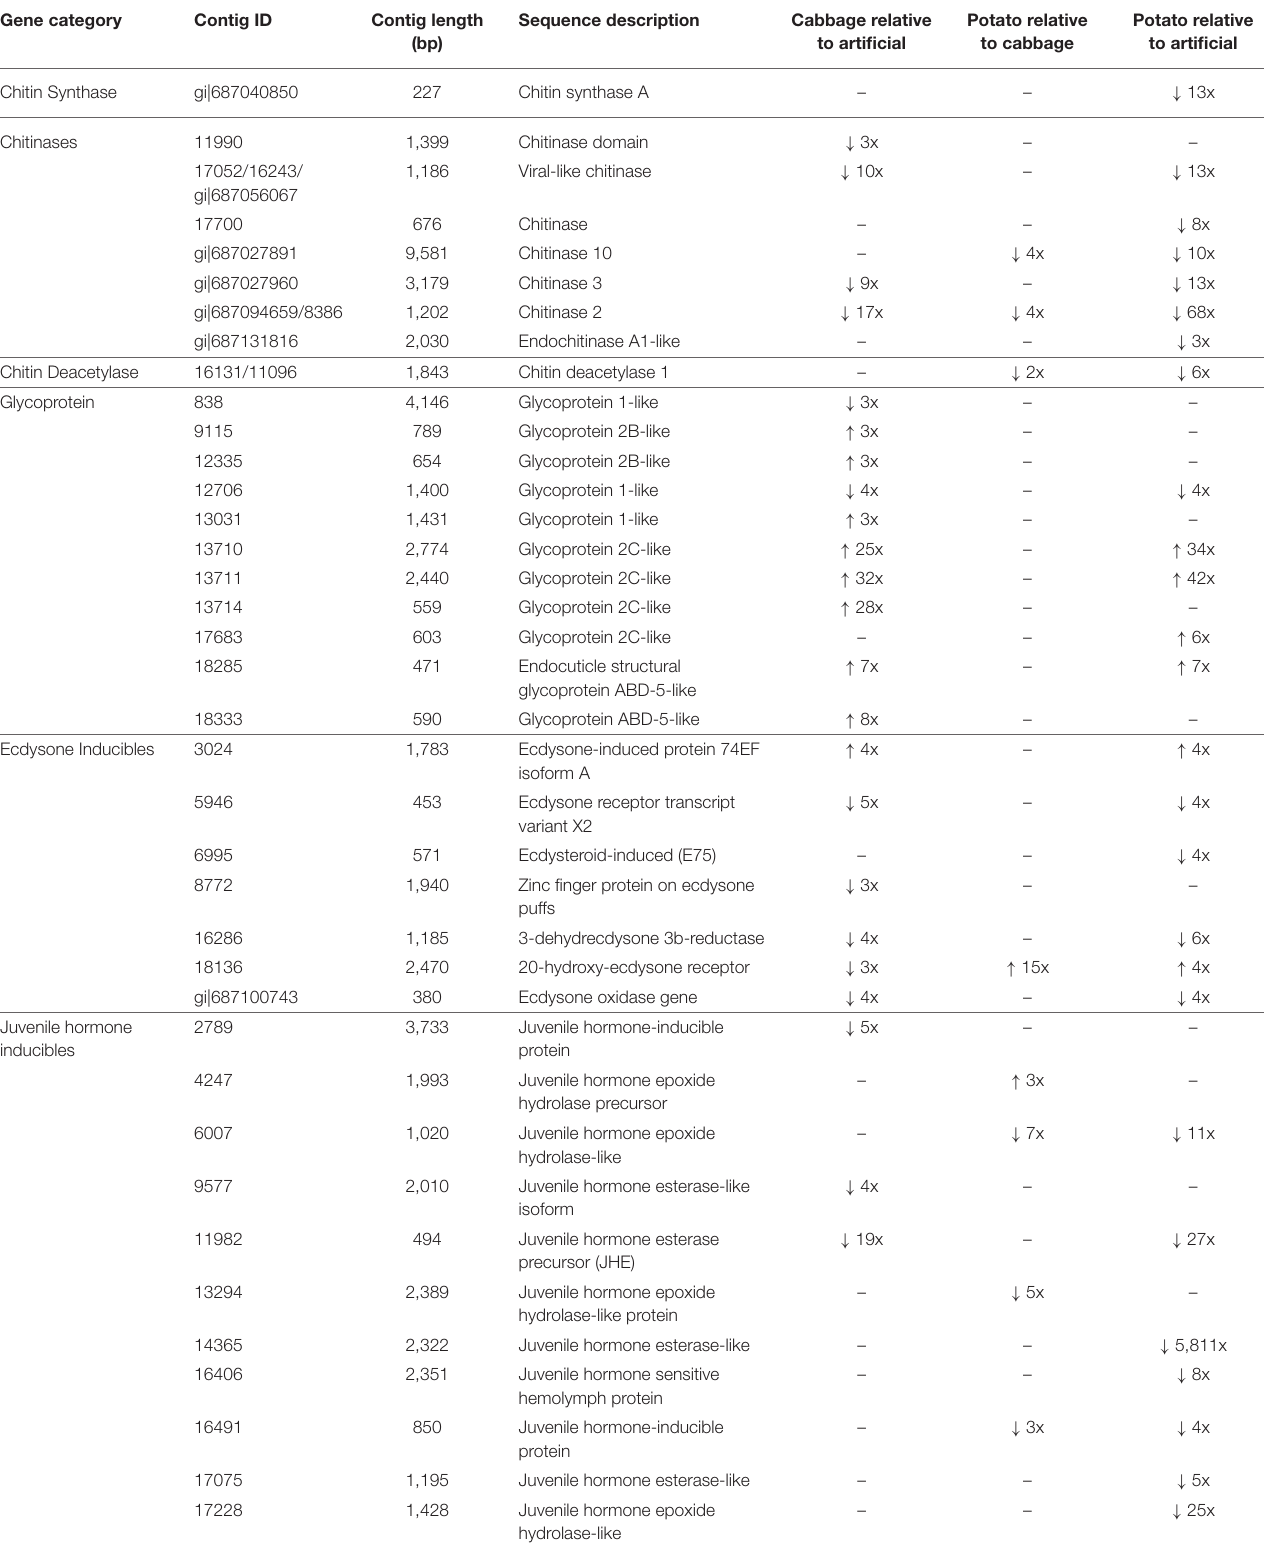
TABLE 1 | Summary of differentially expressed contigs in midguts between all diet group pairs for 4th instar T. ni . Gene